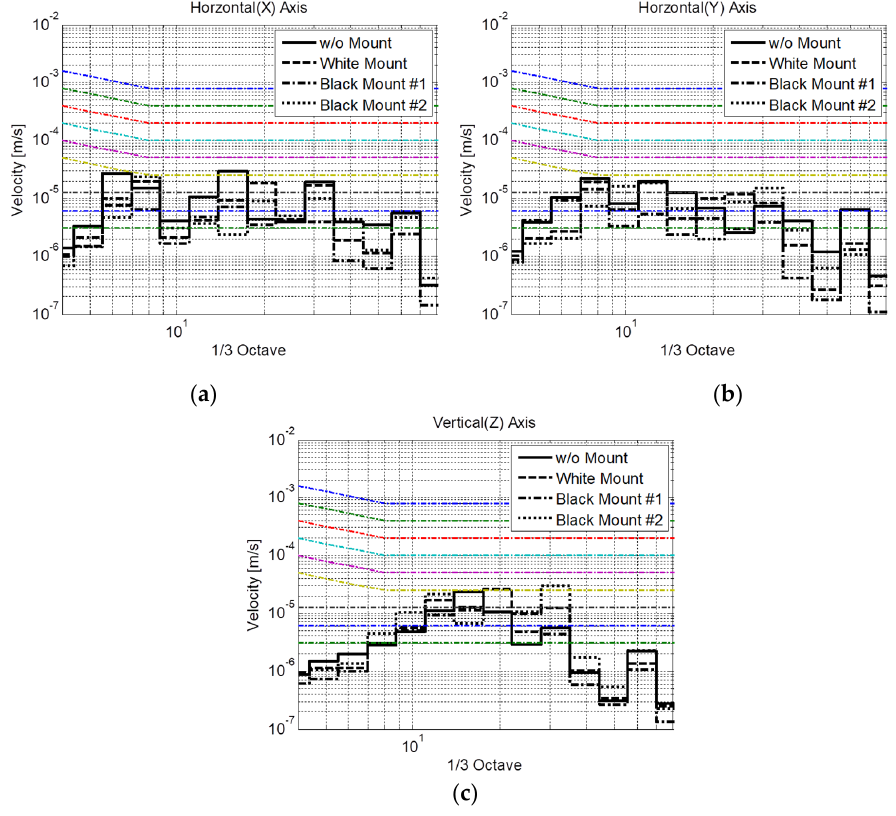
Figure 9. Operational vibration in the directions of ( a ) x -axis, ( b ) y -axis, and ( c ) z -axis compared to the generic vibration criteria with three different types of mounts.